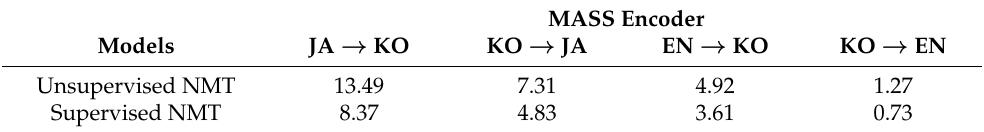
Table 4. The performances of word